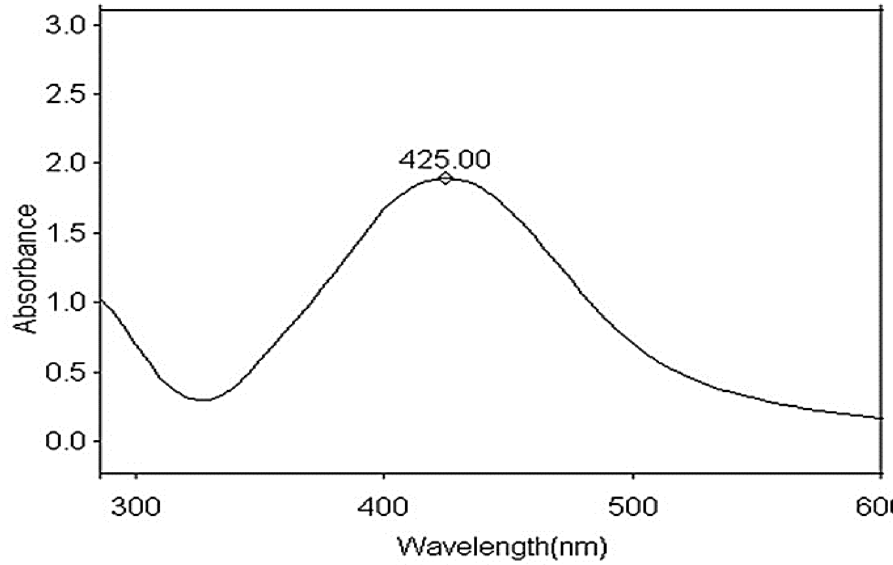
Figure 3. UV–visible absorption spectrum of silver nanoparticles stabilized in